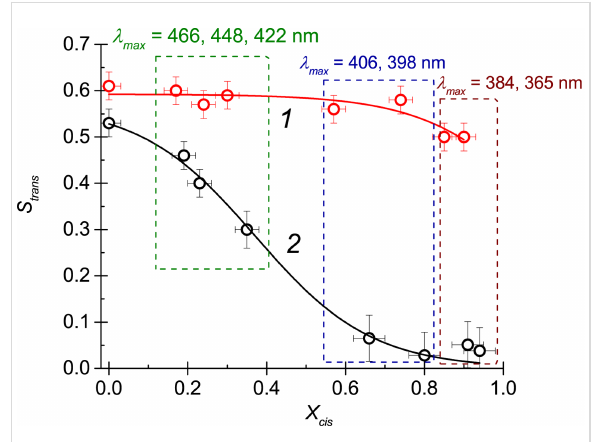
Figure 6: The trans isomer order parameter, S trans , as a function of the relative concentration of cis isomers, X cis , for (1) NLC doped with monomer M and (2) NLC doped with dendrimer